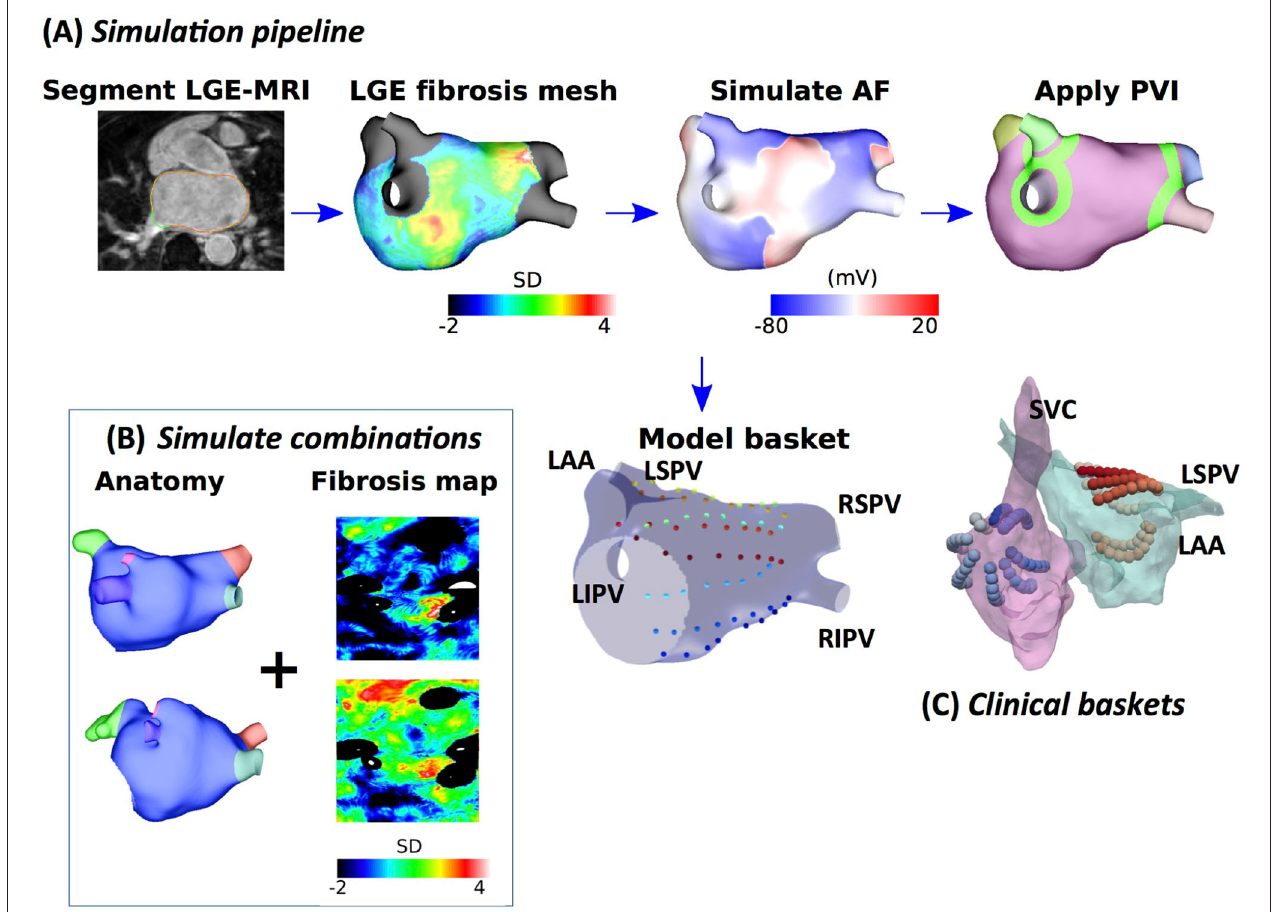
FIGURE 1 | Schematic showing the steps in model construction, simulation, and post-processing. (A) Imaging data were segmented, and simulation meshes were created incorporating conductivity and ionic changes in areas of fibrotic tissue identified using LGE-MRI intensity values. Atrial fibrillation (AF) was simulated and analysed at a basket arrangement of points modelled based on clinical electrode locations. Pulmonary vein isolation (PVI) was applied after 5s. (B) Models were generated for different combinations of anatomy and fibrosis distribution to build a virtual patient cohort of 100 models. (C) Simultaneous biatrial contact mapping was performed with two 64 electrode Constellation